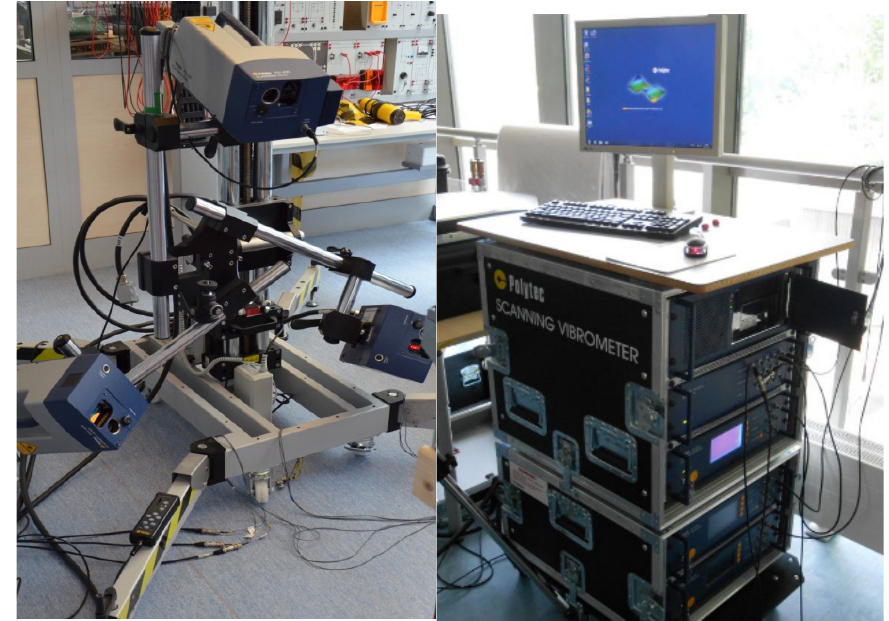
Figure 3. Scanning laser